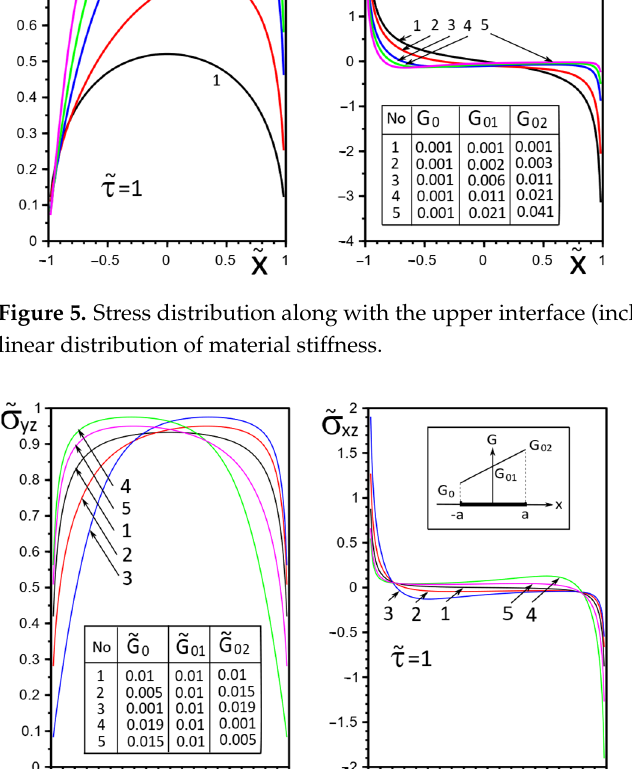
Figure 6. Stress distribution along with the upper interface (inclusion–matrix half-space S 2 ) with a linear distribution of material stiffness.